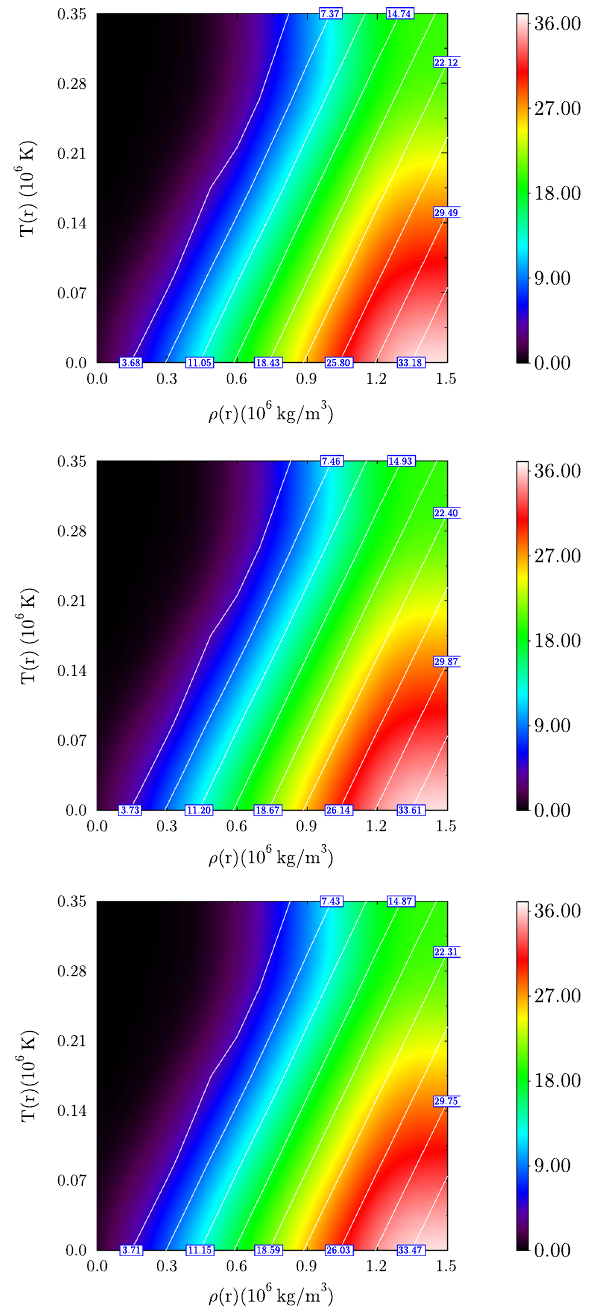
Fig. 3 Profile of the BD predicted by BH, and EiBI theories for a certain ρ c using the γ and κ values with the minimum of the chi-square. Thefiguresshowthedistributionofthetemperature,energydensity,and pressure of each gravity theory (cid:6) = 1 . 4 × 10 2 4 (ρ X D / T 2 / 3 pd